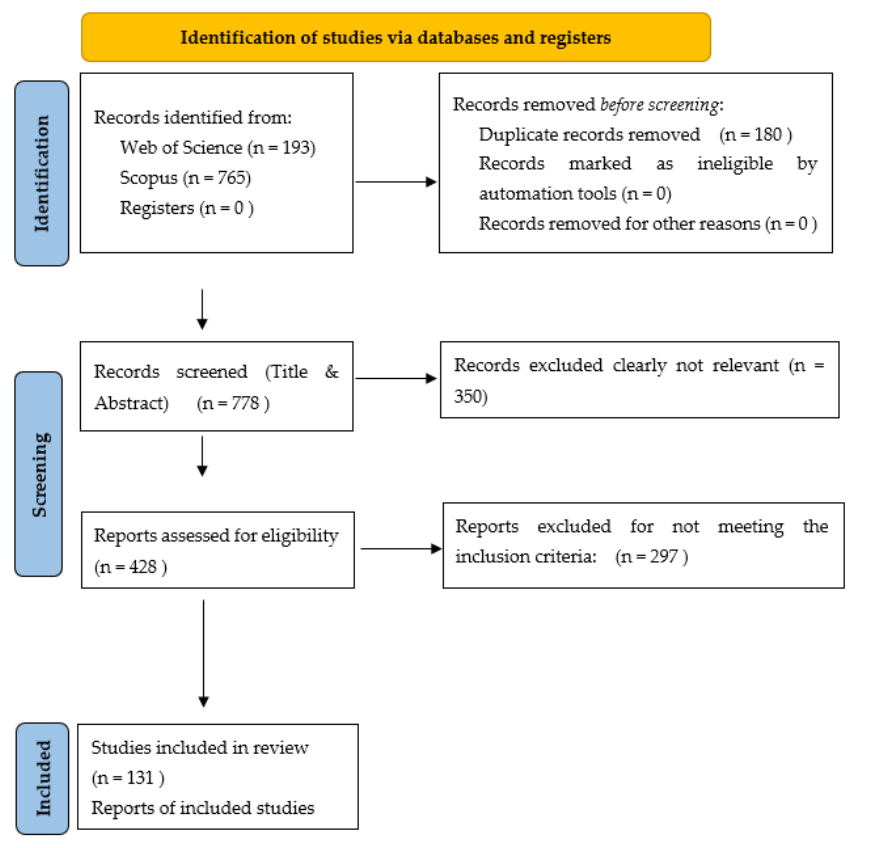
Figure 4. Flowchart. Figure 4.